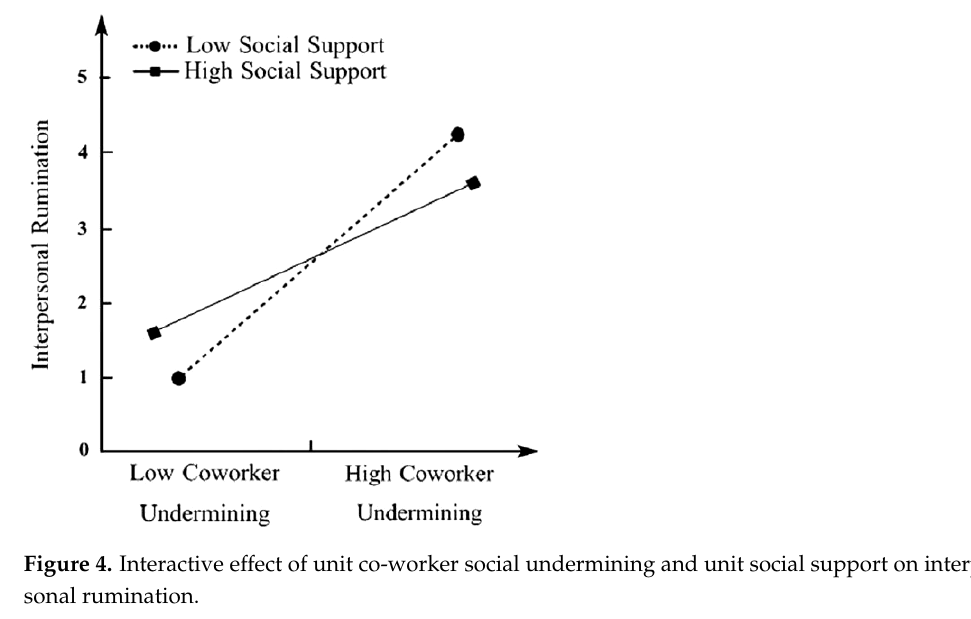
Figure 3. Interactive effect of unit supervisor social undermining and unit social support on interpersonal rumination.